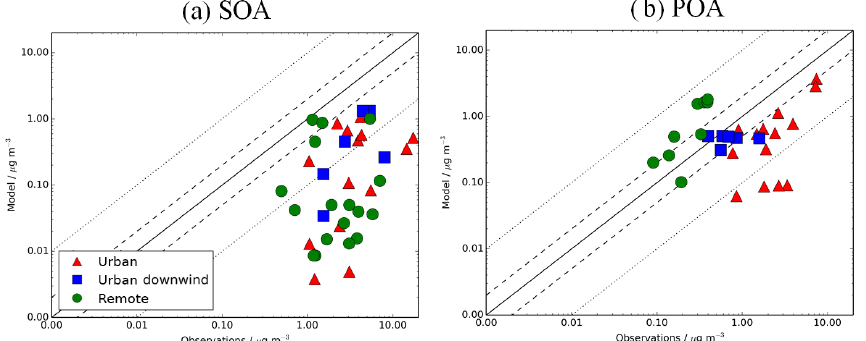
Figure 10. Simulated vs. observed (a) SOA and (b) POA concentrations (µgm − 3 ). Observed OOA is assumed to be comparable to simulated SOA, whereas observed hydrocarbon-like OA is assumed to be comparable to simulated POA. Simulated concentrations are taken from the control run for the year 2000, described in Table 2. Observations for the time period 2000–2010 are classified as urban (red triangles), urban downwind (blue squares), or remote (green circles). The 1 : 1 (solid), 1 : 2 and 2 : 1 (dashed), and 1 : 10 and 10 : 1 (dotted) lines are indicated. Model–observation statistics for SOA, POA and OA are shown in Tables 4, 5, and 6,